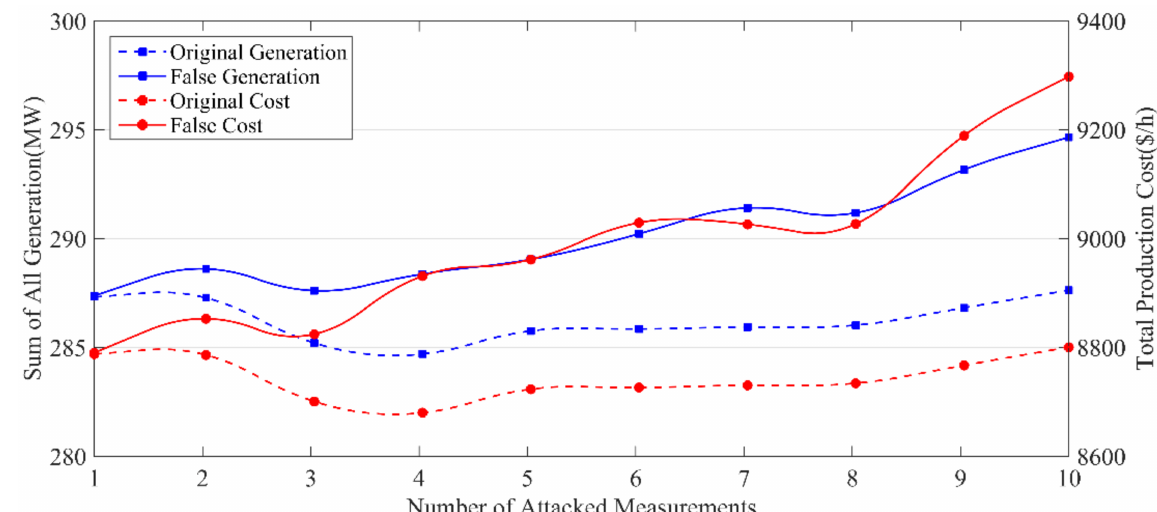
Figure 2. The immediate damaging effect to the power